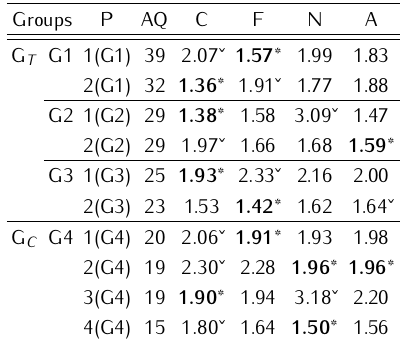
Table 5. Initial success times for the visual stimuli